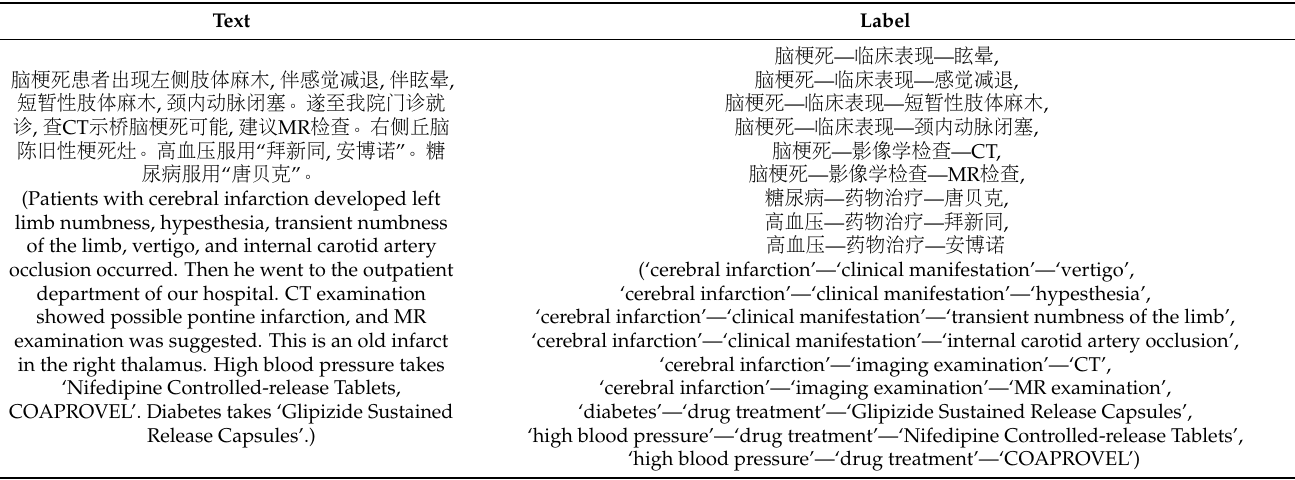
Table 8. Original data of the case study on RC task.